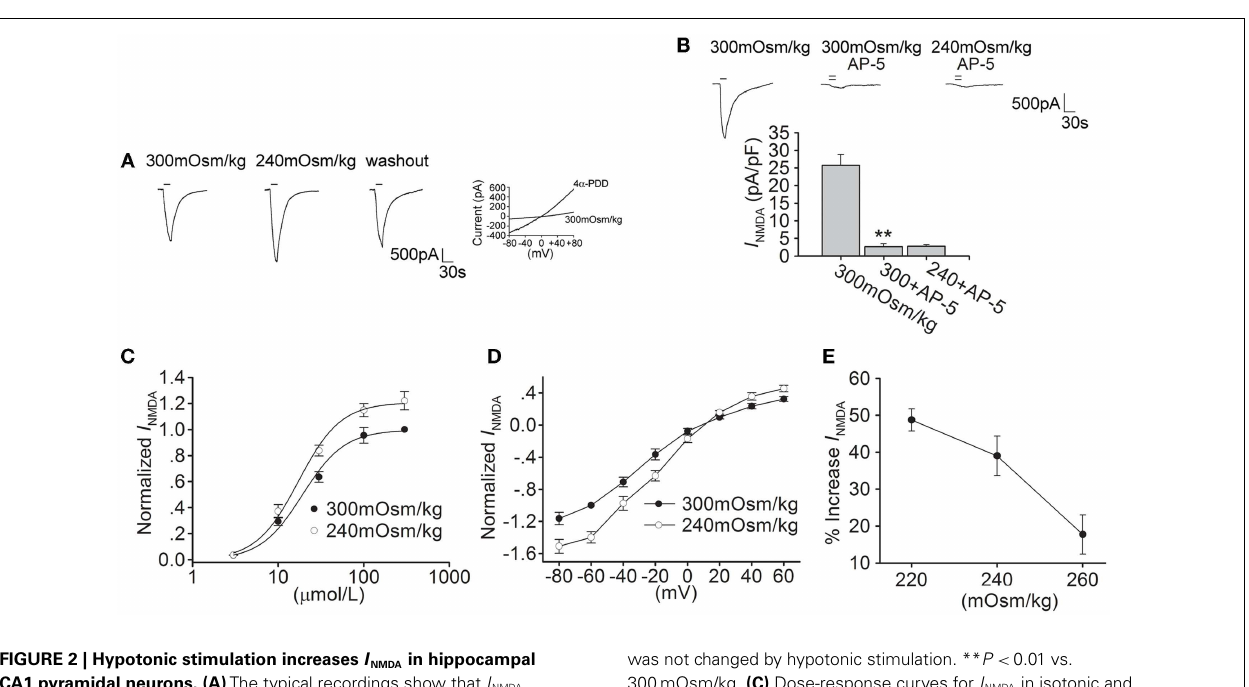
was not changed by hypotonic stimulation. ** P < 0.01 vs. 300mOsm/kg. (C) Dose-response curves for I NMDA in isotonic and hypotonic solution. Each point represents the normalized current from 7 to 17 hippocampal neurons. EC 50 values were 19.23 ± 1.89 and 18.24 ± 1.07 µ M, and n were 1.71 and 1.79 for isotonicity and hypotonicity, respectively. (D) I – V curves were shown in isotonic and hypotonic solution. (E) The plot shows that hypotonic stimuli exhibited more increase in I NMDA with larger osmotic gradient.